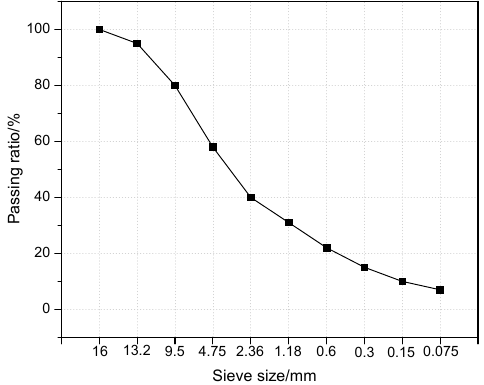
Figure 2. Gradation curve for the sample preparation. Table 3. Properties of SBS-modified bitumen.